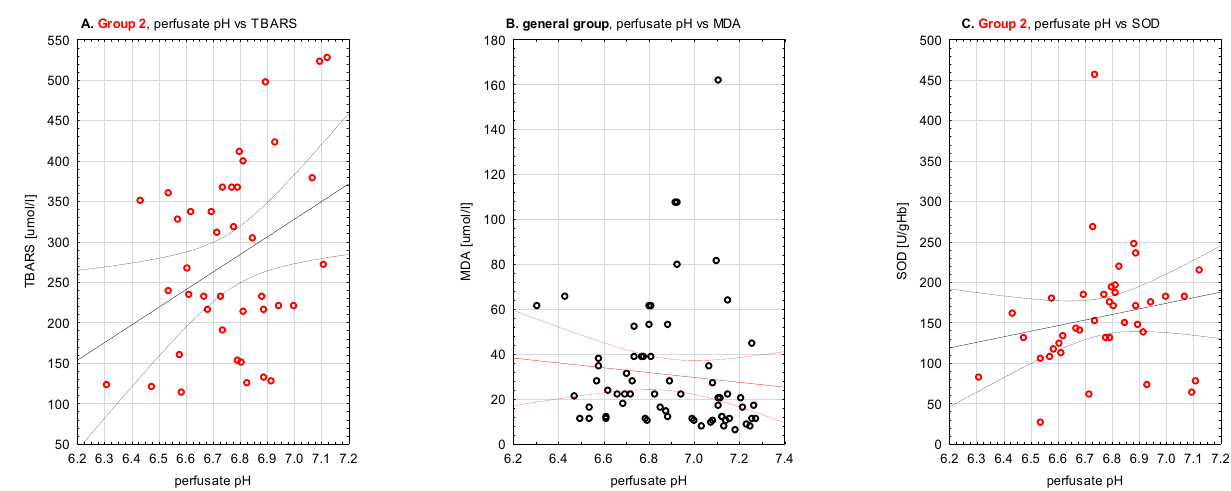
Figure 7. Scatterplots of correlations between perfusate pH and: ( A ). TBARS concentration in Group 2 (SCS) (R Spearman, p < 0.05 , n 2 = 40), ( B ). MDA concentration in the general group (R Spearman, p < 0.05 , N = 66), ( C ). SOD activity in Group 2 (SCS) (R Spearman, p < 0.05 , n 2 = 40).